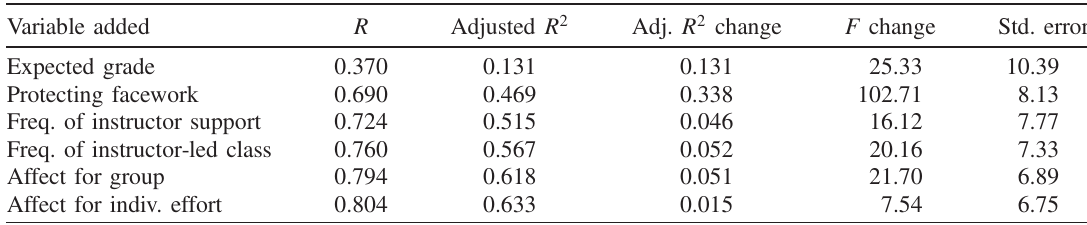
TABLE IX. Regression analysis for course satisfaction, with instructor goodwill removed ( N ¼ 161 ). The improvement to adjusted R 2 is shown for the addition of each